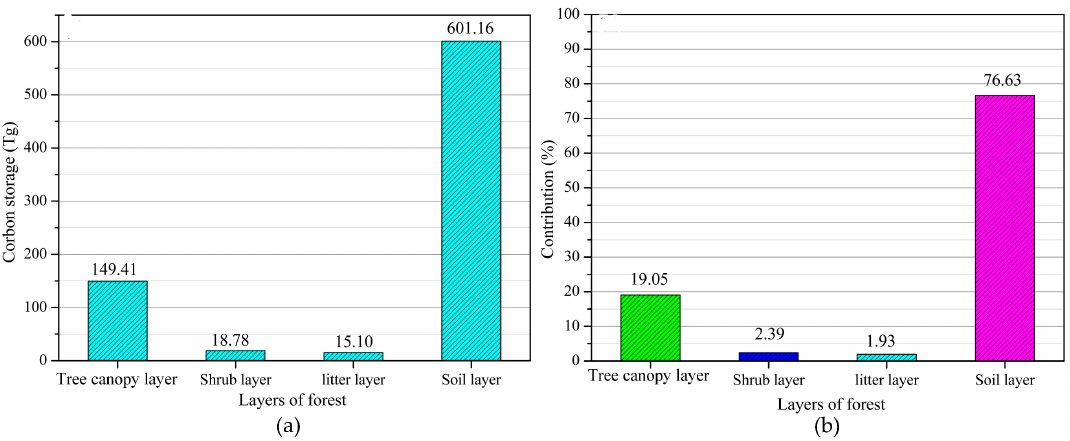
Figure 6. Carbon storage (Tg) in Hubei Province ( a ) and contribution rates (%) of different forest layers in Hubei Province ( b ).